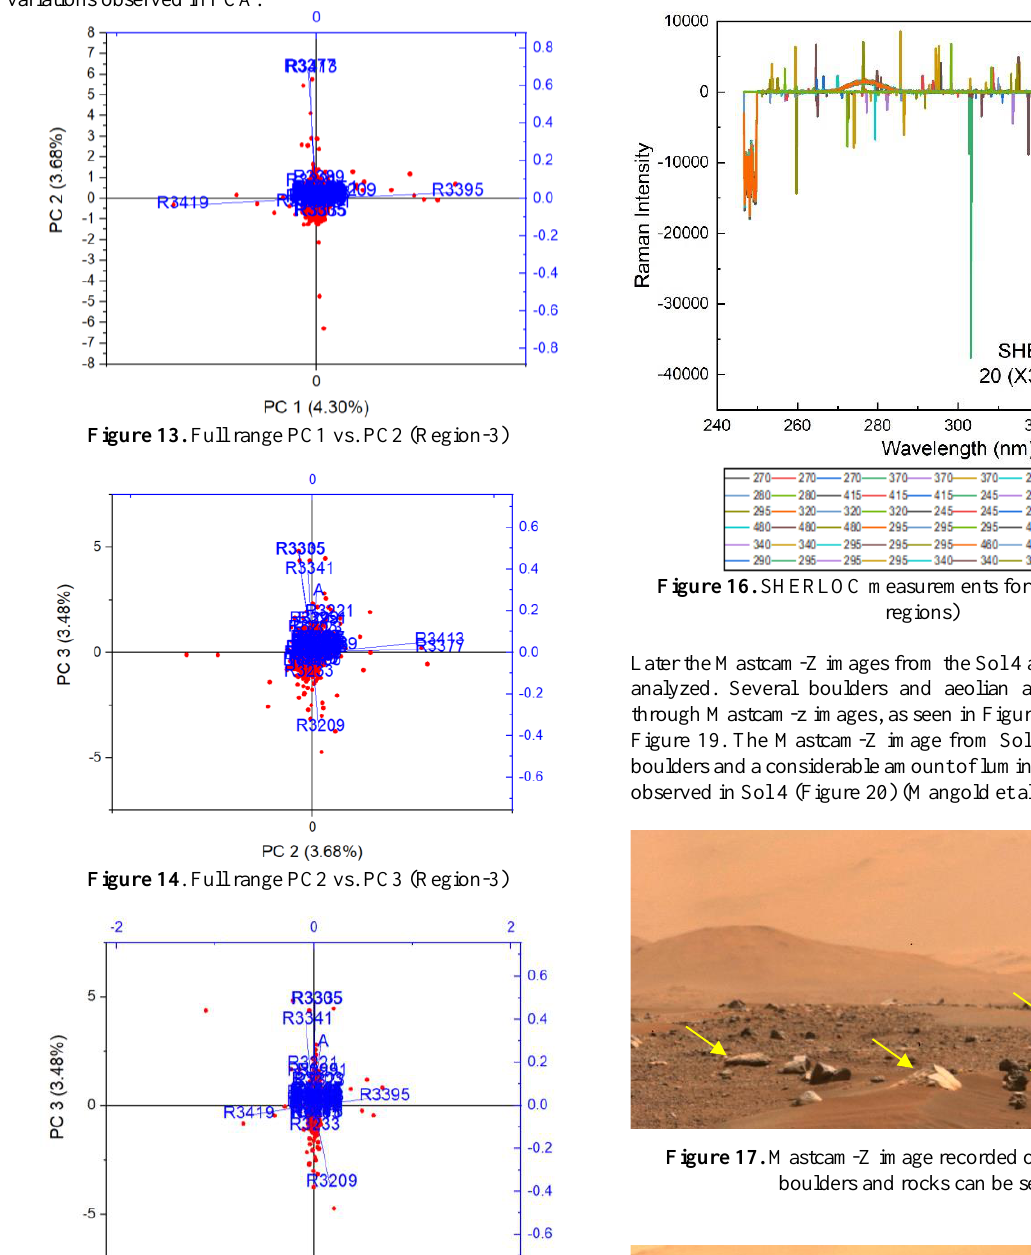
Figure 13. Full range PC1 vs. PC2 (Region-3)